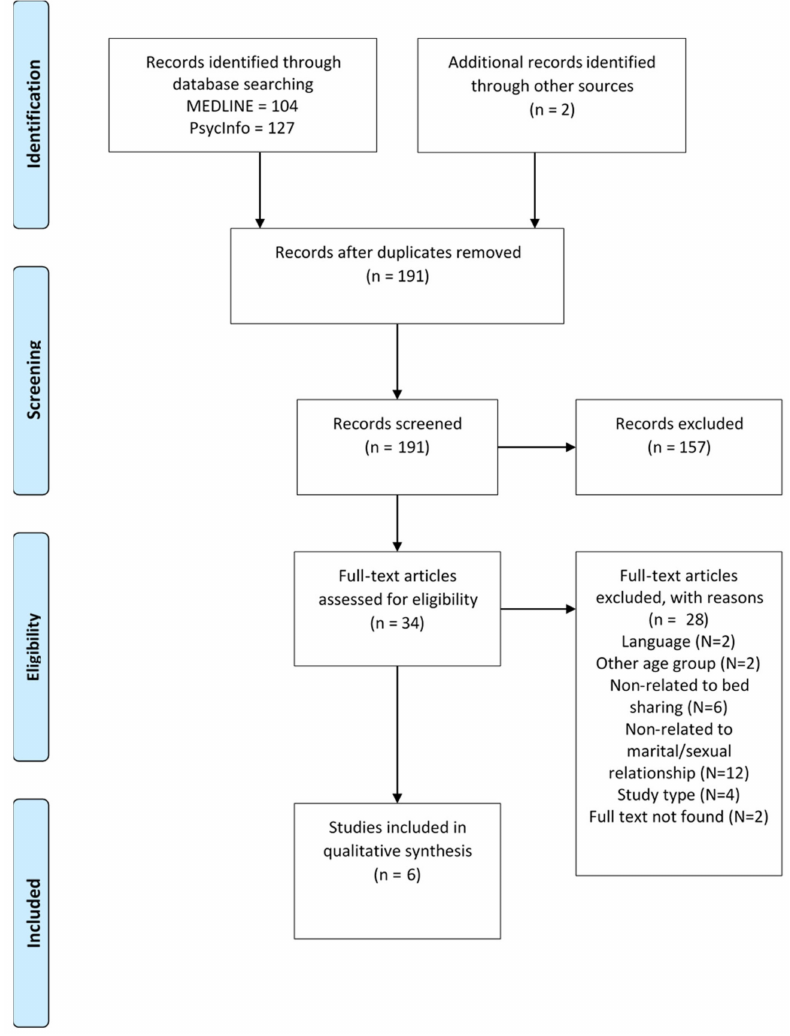
Figure 1. PRISMA flowchart of the scoping review